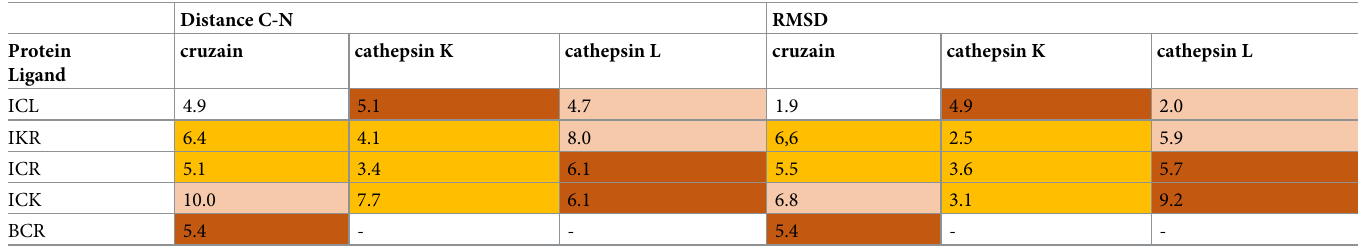
Table 2. Summary of metrics extracted from the MD simulations of the non-covalent ligand-protein complexes: Distance C-N (distance between thiolate of Cys25 and nitrile carbon of ligand, in Å ngstroms) and RMSD of ligands from the initial docked conformation (in Å ngstroms) during the second round of simulations. Cells are colour coded according to experimentally determined inhibitory activity, orange: < 5 nM; tan: < 50 nM; red: > 1000 nM; white: not